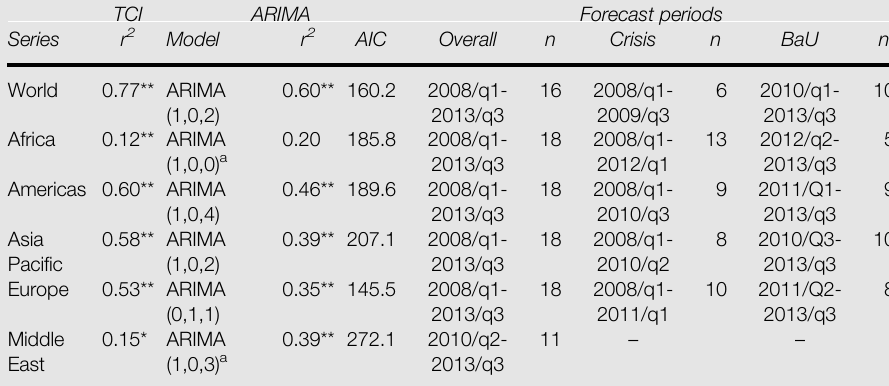
Table I Forecast models, evaluation criteria and